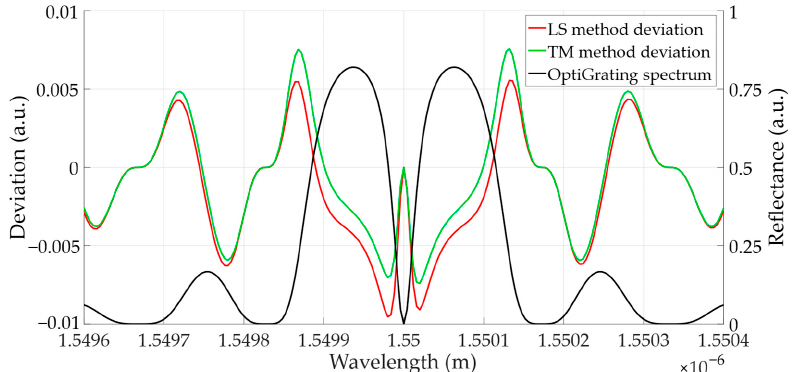
Figure 8. Deviations of the π -phase-shifted FBG spectra from the reference (OptiGrating) spectrum (left axis): deviation of the Layer Sweep method (red line), deviation of the Transfer Matrix method (green line); and reference OptiGrating spectrum (black line, right